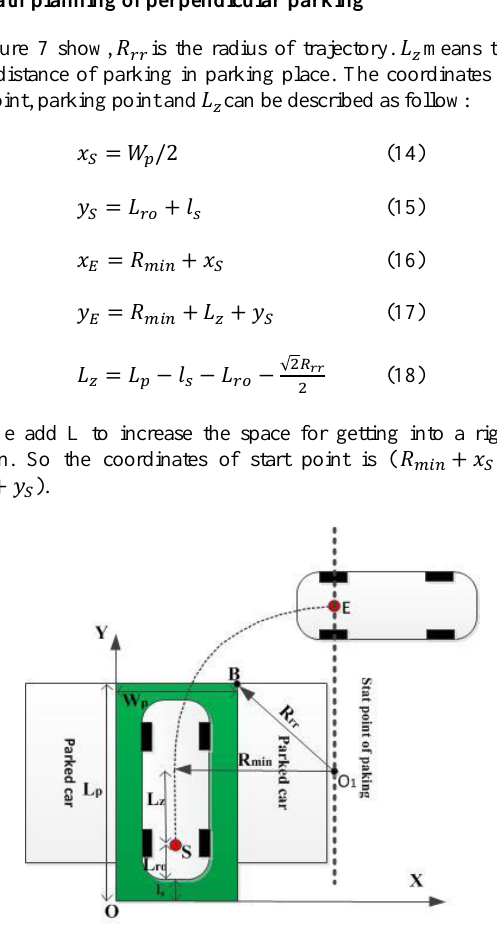
Figure 7. Path planning of perpendicular parking